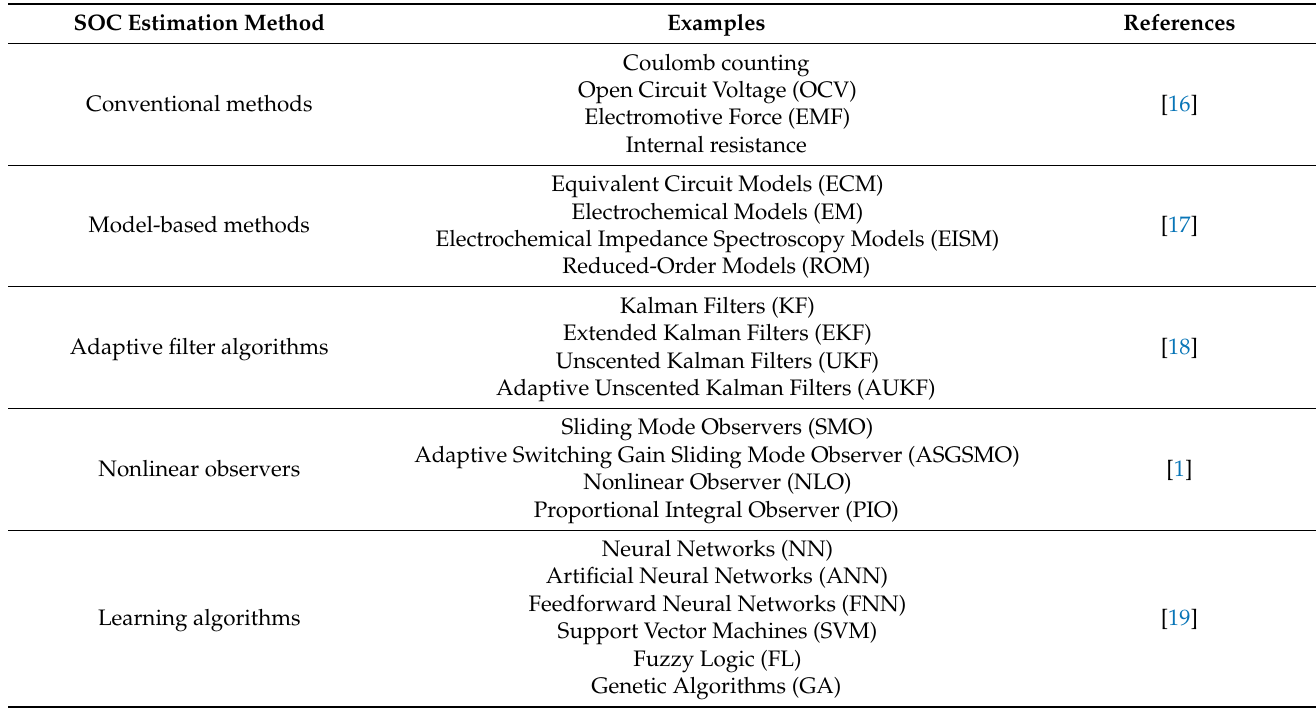
Table 1. Classification of SOC estimation